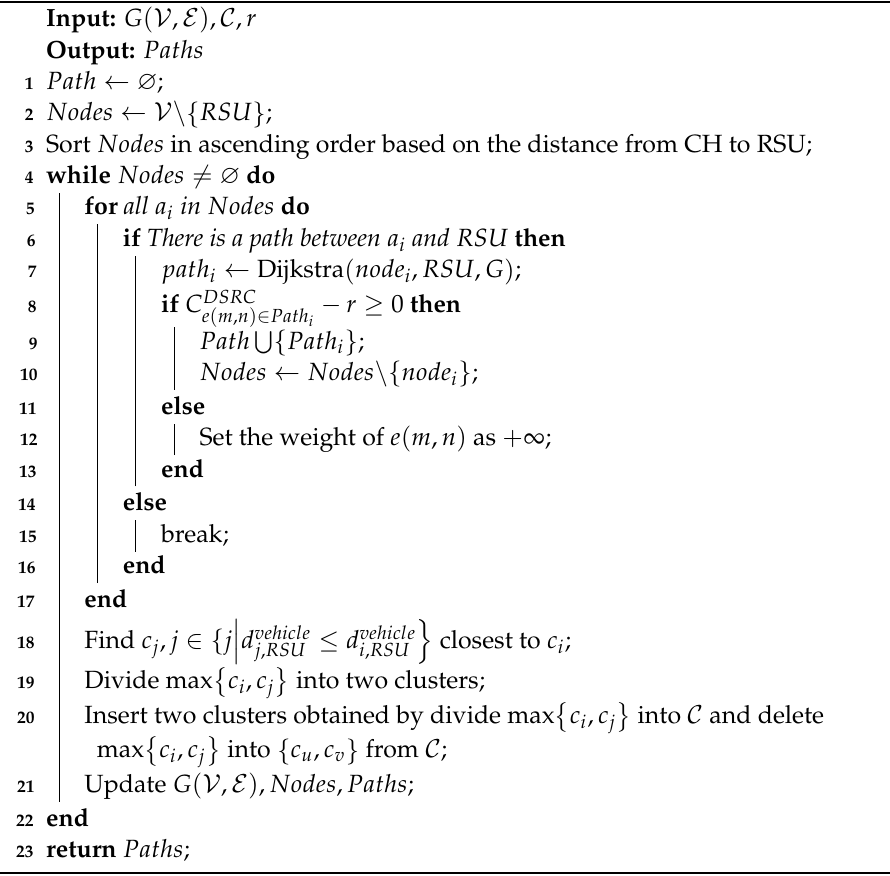
Algorithm 2: Path Construction. The algorithm is used to establish VANET communication links between